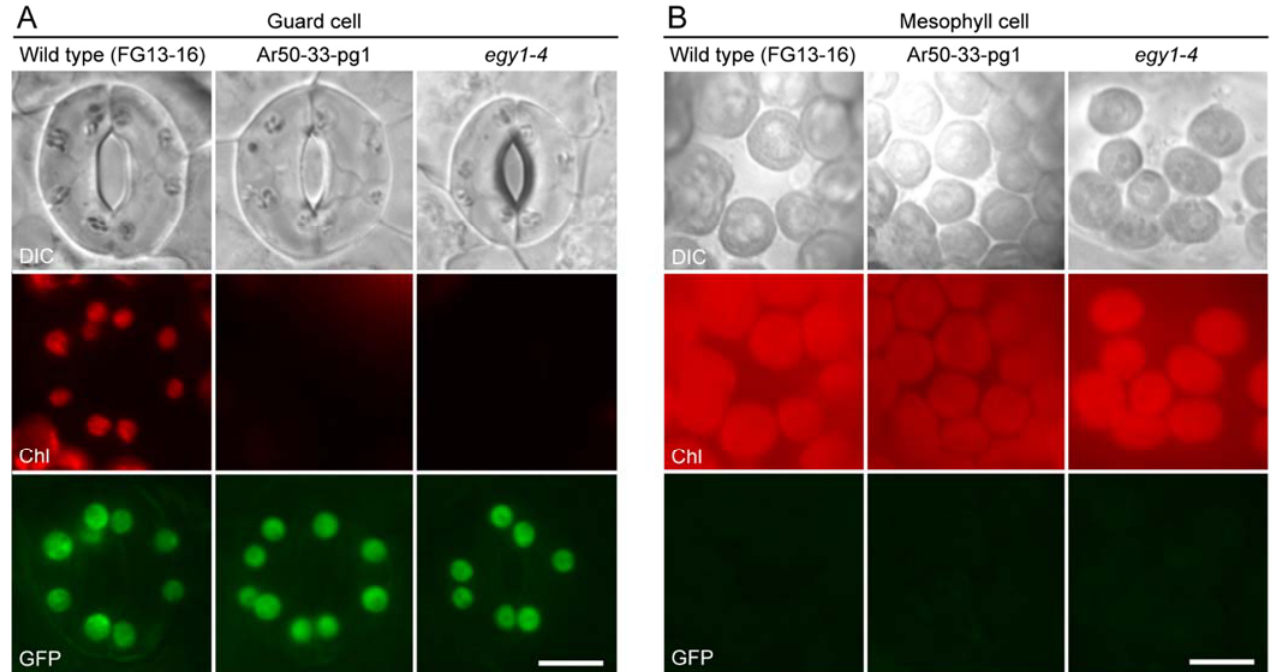
Figure 5. Fluorescence microscopy of cotyledon epidermis in the wild-type and mutant lines expressing stroma-targeted fluorescent proteins. ( A , B ) DIC, chlorophyll autofluorescence (Chl), and GFP images of guard cells ( A ) and mesophyll cells ( B ) in the abaxial epidermal peels of cotyledons of 1-week-old seedlings. Bar = 10 µm.